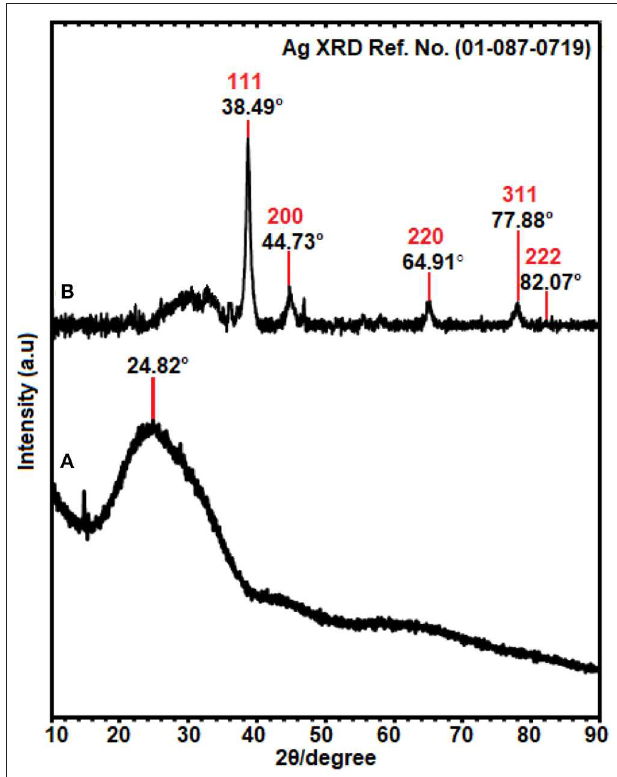
FIGURE 3 | The XRD patterns of (A) E. spiralis extract (2.5g) and (B) E. spiralis /Ag-NPs at the best parameters to synthesize